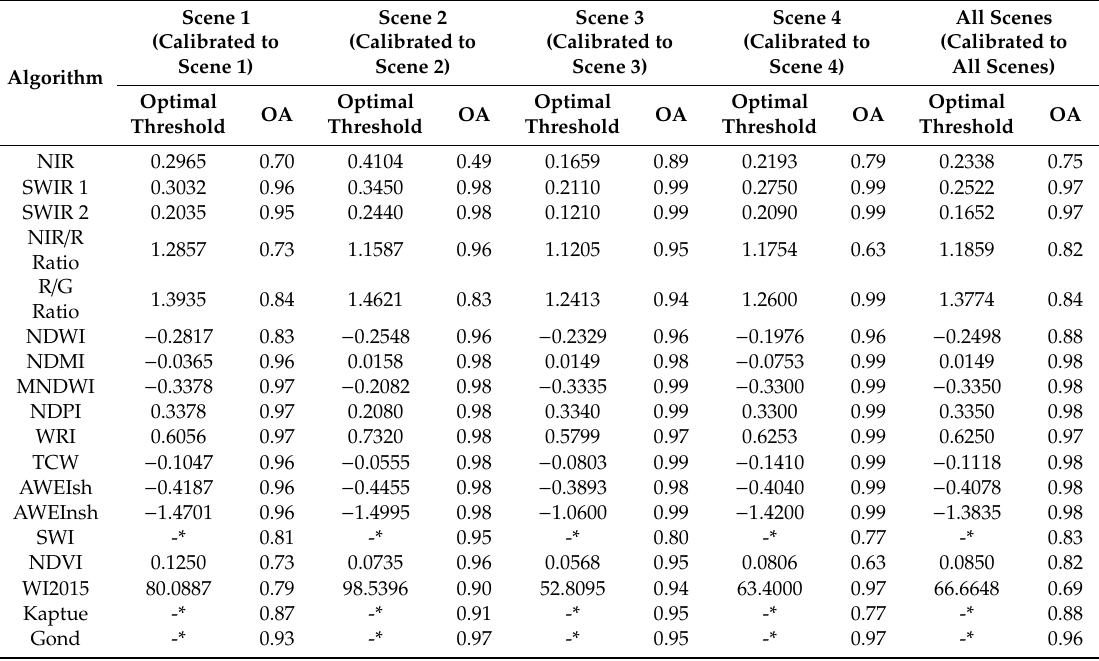
Table 5. Accuracy results for